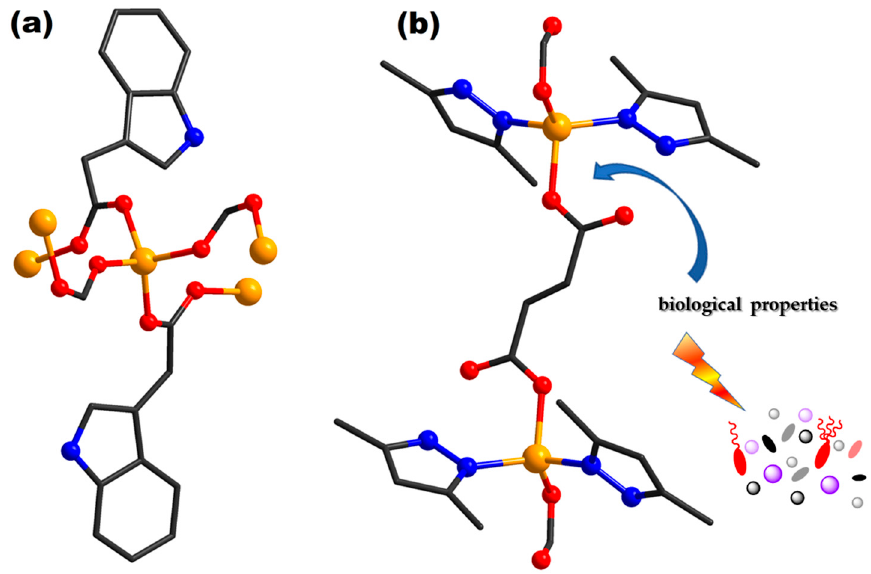
Figure 4. Coordinative site of complexes [Zn(I2cah) 2 (H 2 O) 2 ] n ( 86 ) ( a ) and {[Zn 2 (fum) 2 (Hdmpz) 4 ]·3H 2 O} n ( 93 ) ( b ) (adapted from ref. [100,105]). For [Zn(bfmta)(H 2 O) 2 ] n ( 88 ) (H 2 bfmta = 2,5-bis(furan-2-ylmethylcarbamoyl)tereph- thalic acid), biological tests were developed using Gram-positive ( B. subtilis, S. aureus ), Gram-negative ( E. coli, Salmonella typhi ) bacterial and fungal strains ( Penicillium expansum, Botry- depladia thiobromine, Nigrospora sp., Trichothesium sp.) and were discussed in comparison with ciprofloxacin. The results evidenced that the antibacterial and antifungal activity of the complex is lower than of the standard drug but higher than of the free ligand (bfmta). The inhibition zones against bacterial strains are above 30 mm, whereas they are between 24 and 30 mm against fungal strains. Additionally, the antibacterial activity of ( 88 ) is higher than that of similar complexes with Mn(II), Co(II), or Ni(II) [101]. A different Zn(II)-CP, [Zn 4 (bdc) 4 (ppmh) 2 (H 2 O)] n ( 89 ) (H 2 bdc = 1,4-benzene dicar- boxylic acid; ppmh = N- pyridin-2-yl- N’ -pyridin-4-ylmethylene-hydrazine), has proven its efficiency as an antibacterial agent against E. coli and S. aureus , being more active than the free ligands. As liver cancer is a malignant tumor with high incidence worldwide, finding new therapeutic agents has gained great importance. For example, complex ( 89 ) is also a potential antitumor agent against liver (HepG2) cell lines. The assay indicates that viability decrease in parabolic dependence with increasing concentration with an LD 50 value of 42.2 ± 2.3 µ g/mL. Ligands did not evidence any impact at levels up to 120 µ g/mL and the positive control (cisplatin) had an LD 50 value of 12.6 ± 2.8 µ g/mL [102]. Complex [Zn(pab)(OH)(H 2 O) 2 ] n ( 90 ) has been reported [103] for its antibacterial activity against Gram-positive ( B. subtilis, S. aureus, Enterococcus faecalis ) and Gram-negative ( P. aeruginosa , Enterobacter cloacae ) strains, and activity was enhanced in comparison to free ligand (Hpab). The lowest MIC (12.5 µ g/mL) was found for E. faecalis, P. aeruginosa and E. cloacae . Additionally, ( 90 ) presents antitumor activity against breast cancer (MCF-7), cervical cancer (HeLa), and cellosaurus (NCI-H446) cell